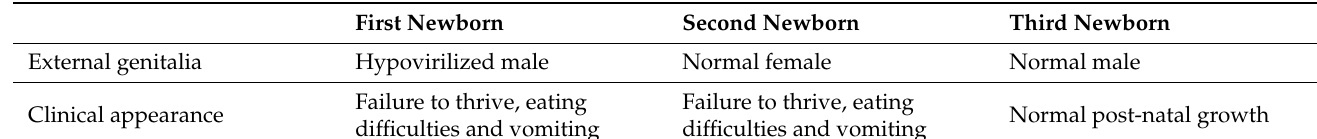
Table 1. Clinical, instrumental and laboratory findings of newborn triplets investigated for salt wasting congenital adrenal hyperplasia (SW-CAH). First Newborn Second Newborn Third Newborn External genitalia Hypovirilized male Normal female Normal male Failure to thrive, eating Failure to thrive, eating Normal post-natal Clinical appearance difficulties and vomiting difficulties and vomiting